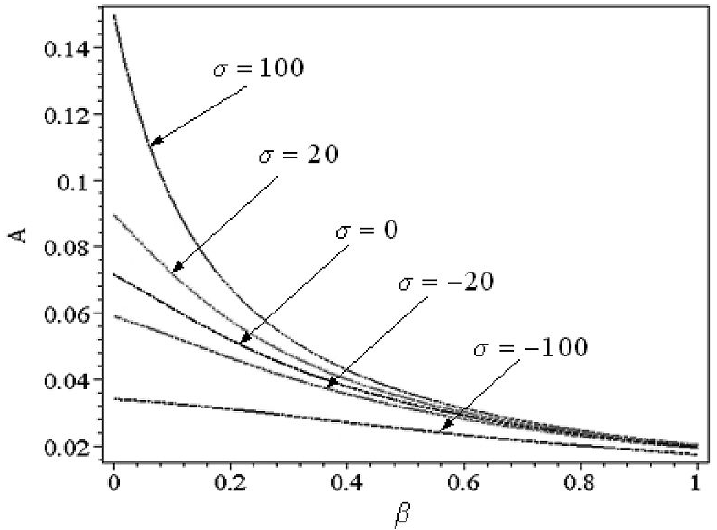
Fig. 7. Amplitude of the response as a function of the squeeze film damping for several values of σ